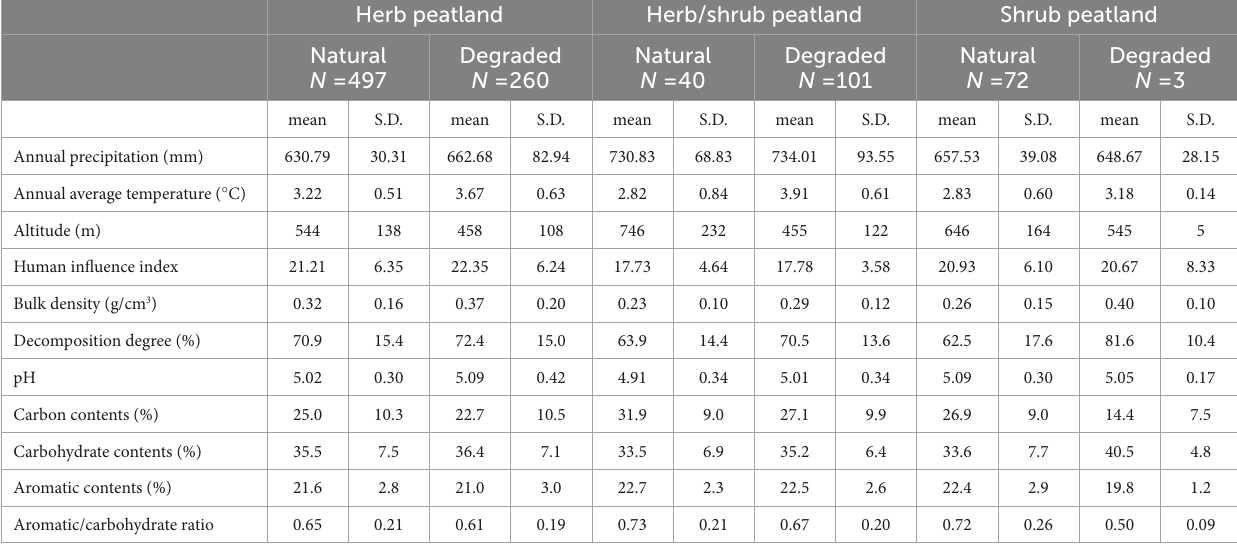
TABLE 1 Basic information of selected peat soils in different dominated plant types of natural and degraded